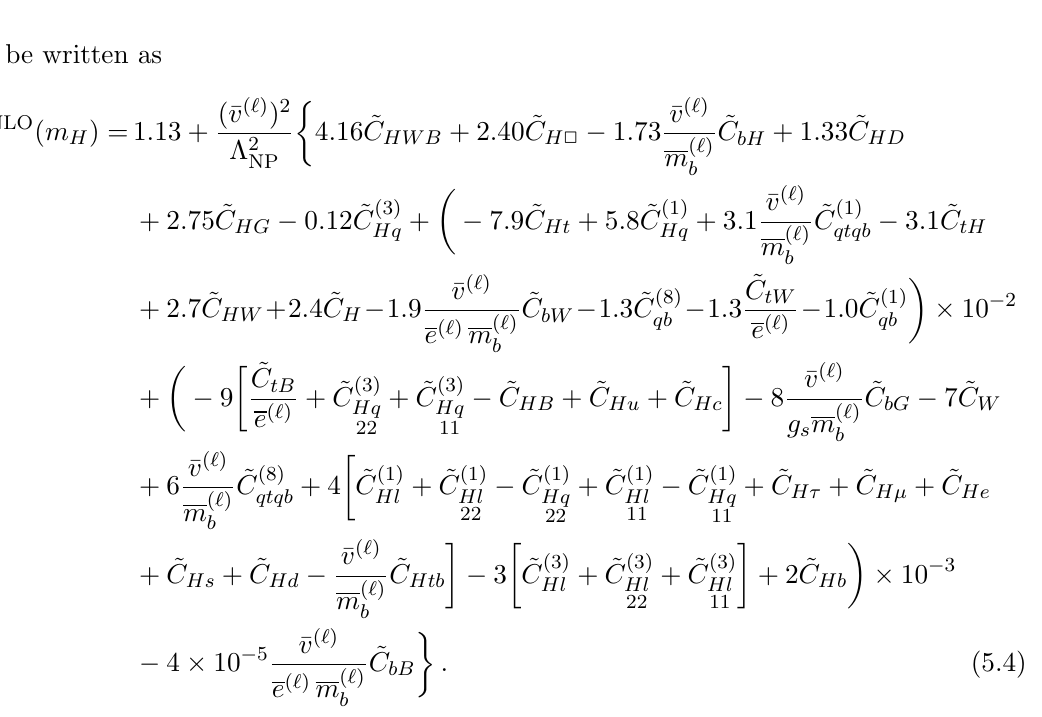
Table 2 . Size of NLO corrections to di(cid:11)erent terms in LO decay rate, split into QCD-QED, large m t , and remaining components. See text for further